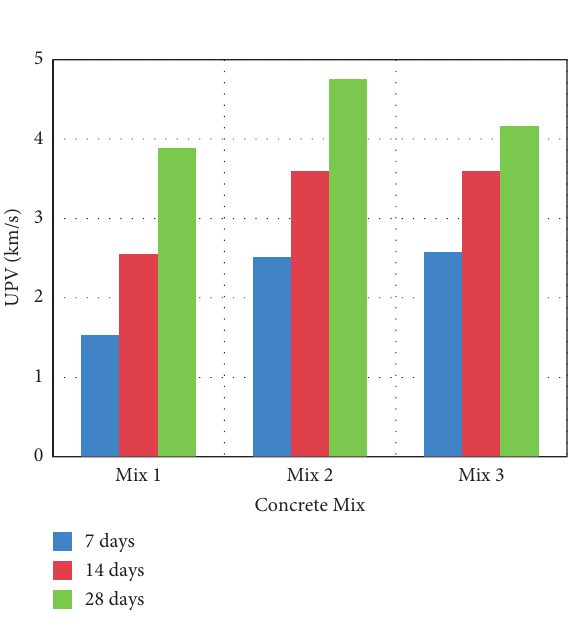
Figure 2: UPV value for GPC for different proportions. Table 10: Rebound number for